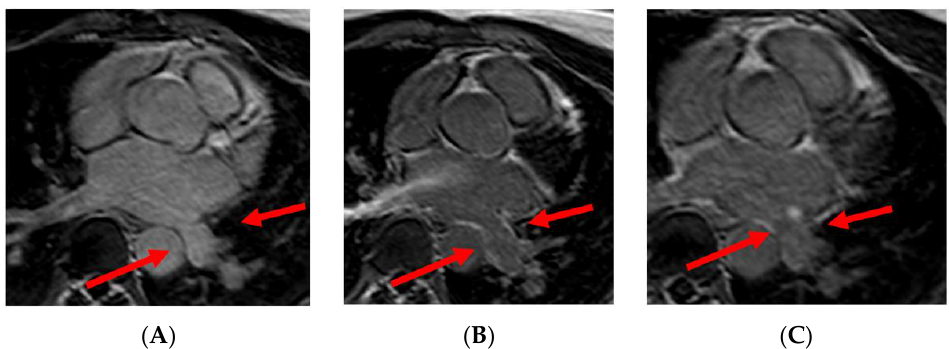
Figure 5. Panel ( A ): preprocedural LGE; postprocedural LGE at 24 h (panel ( B )) and 30 days (panel ( C )) after cryoablation. Red arrows indicate the pulmonary vein ostia.